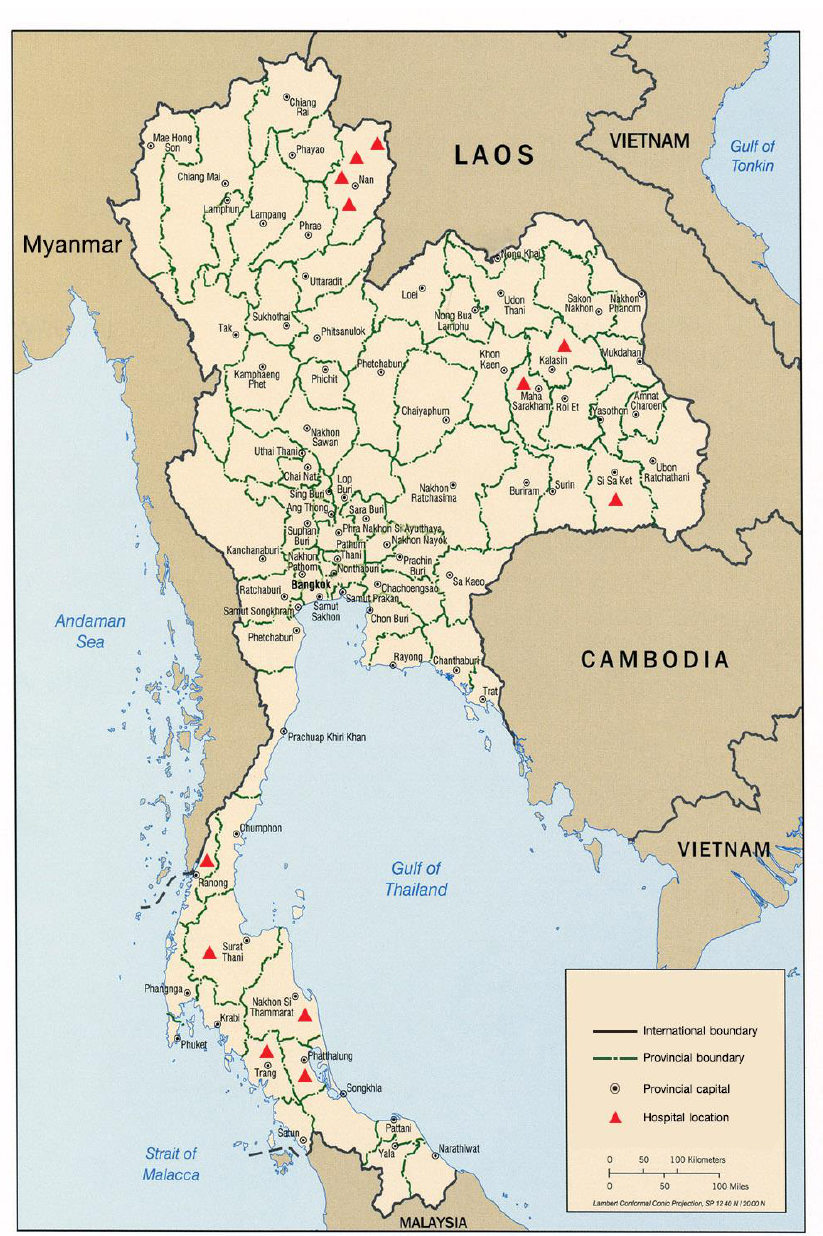
Figure 1. Location of the 12 hospital-based sites in Thailand, 2017.